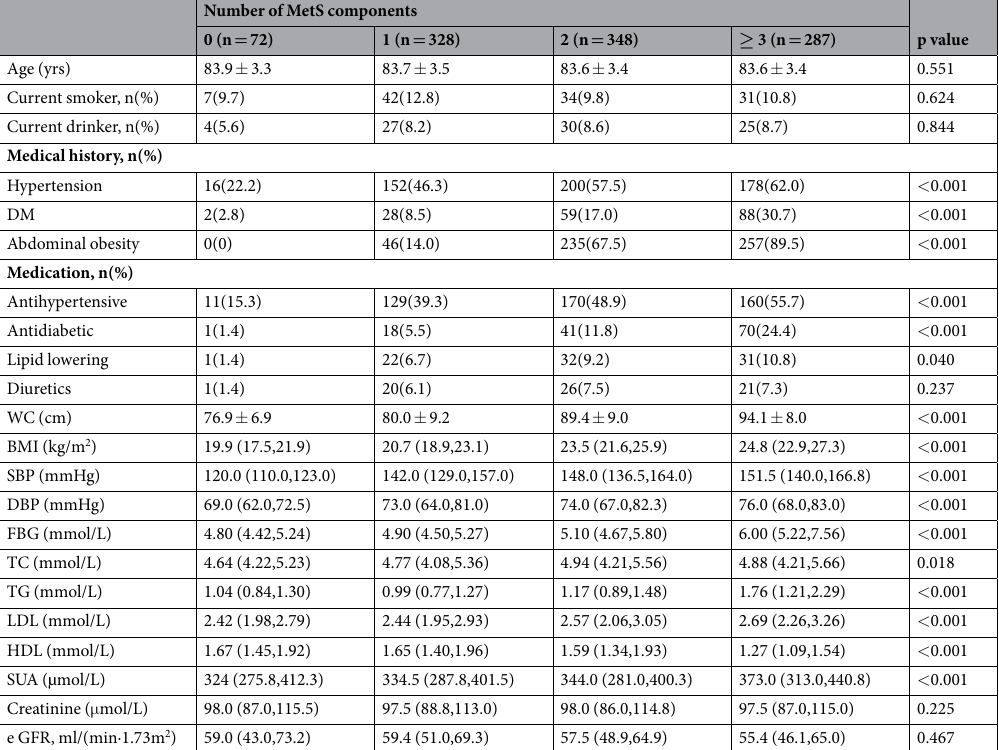
Table 1. Characteristics of community very elderly Chinese in Chengdu. Data are expressed as mean ± standard deviation for normal distributed continuous variables, median (interquartile range) for skewed continuous variables, or number (percentage) for categorical variables. BMI: body mass index; DBP: diastolic blood pressure; DM: diabetes mellitus; eGFR: estimated glomerular filtration rate; HDL: high-density lipoprotein; LDL: low-density lipoprotein; SUA: serum uric acid; SBP: systolic blood pressure; TC: total cholesterol; TG: triglyceride; WC: Waist circumference.